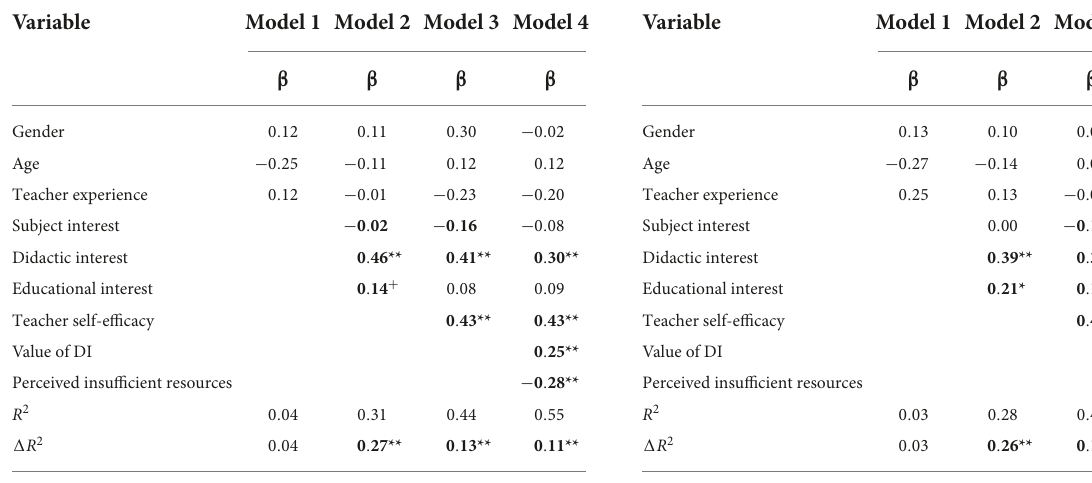
TABLE 3 Multiple regression models: prediction of teachers’ academic progress